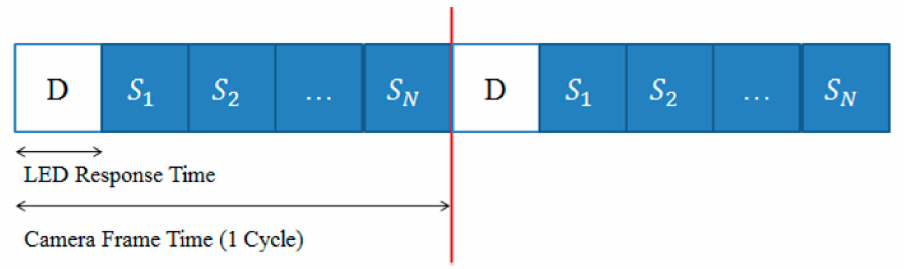
Figure 10. Structure of the transmitted data for time-sharing-based synchronization [25]. The white (D) and blue (S) sections represent information symbol (color) data and synchronization data, respectively. Here, S 1 − S N are symbols generated from the color-space-based constellation.